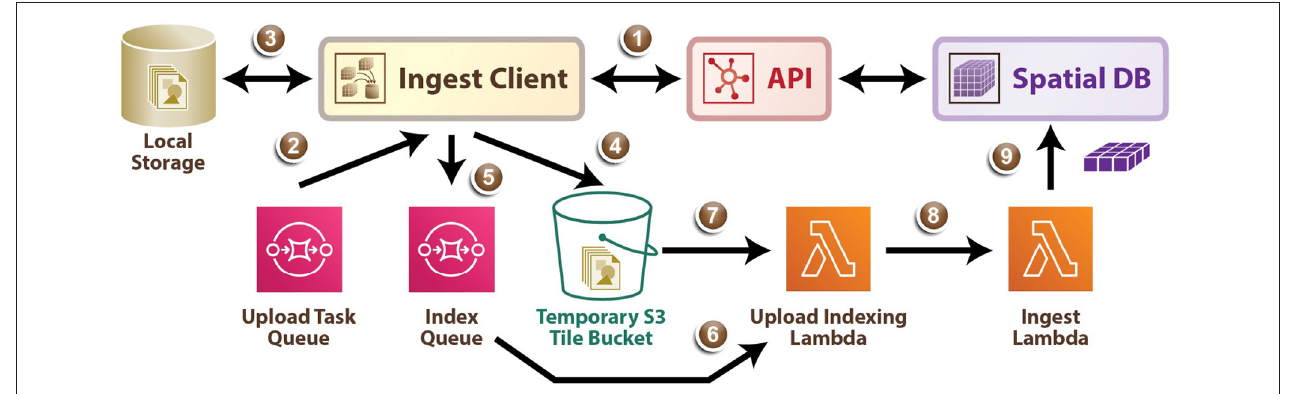
FIGURE 5 | A diagram outlining the data ingest service